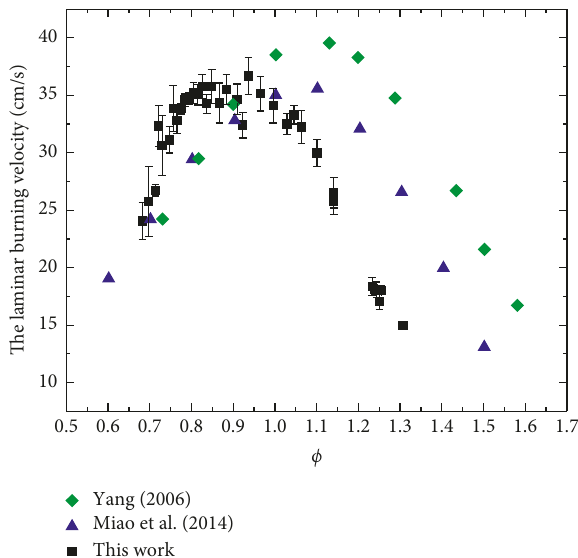
Figure 8: Comparison laminar burning velocity (SL) between present work with previous work in literature: ( ◆ green solid diamond) for 50% of C 3 H 8 +50% of n-C 4 H lO /air mixture by Yang [37], ( ▲ blue solid triangle) for LPG gas by Miao et al. [38], and ( ■ black solid square) for Saudi LPG/air using the modified Bunsen burner in this